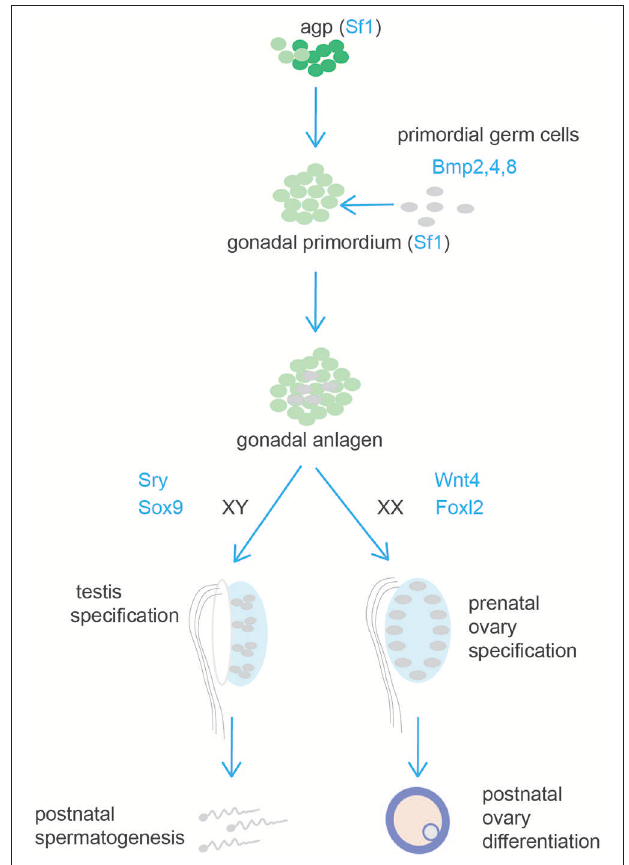
FIGURE 6 | Schematic representation of testis and ovary development. Cells from the adrenogonadal primordium (agp) form the gonadal anlagen. The gonadal anlagen is invaded by migrating primordial gem cells that derive from the region of the forming hindgut. Expression of Sry/Sox9, and Wnt4/Foxl2 determine gonad differentiation into testis or ovaries,